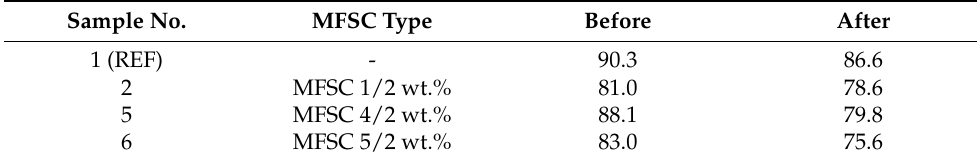
Table 4. Gloss values of tested samples before and after exposure in the aging chamber. Sample No.